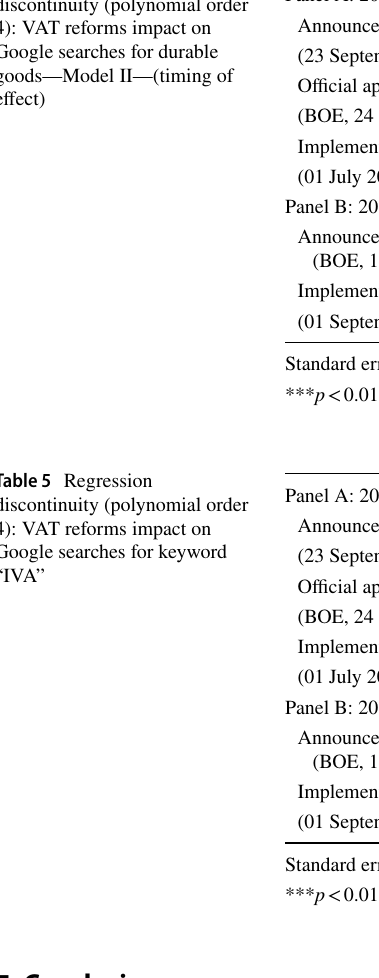
discontinuity (polynomial order 4): VAT reforms impact on Google searches for durable goods—Model II—(timing of effect)